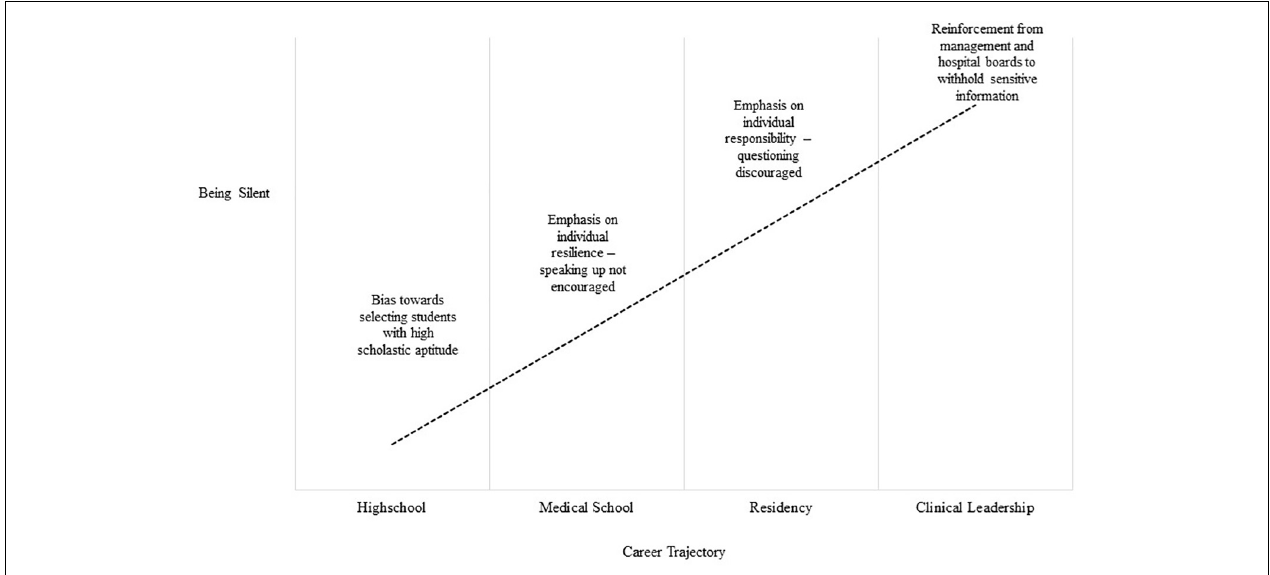
FIGURE 1 | Examples of forces contributing to